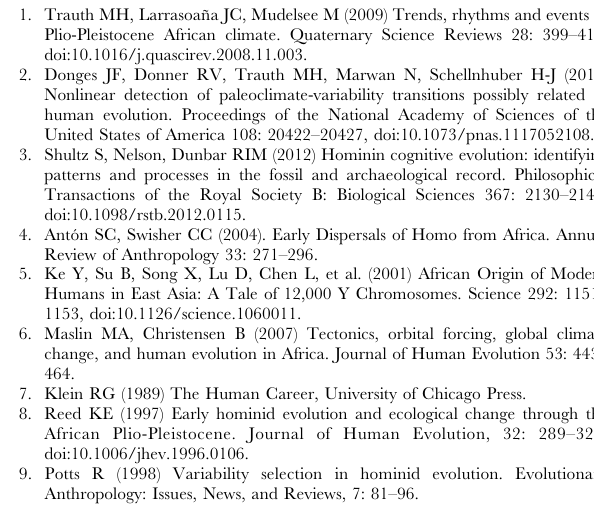
Table S7 Migration models for three migration scenarios. Table S8 Best fit models for brain capacity over all hominins. Table S9 Regional brain capacity models Figure S1 Comparison of the probability of a dispersal or migration event out of East Africa with the Lake variability